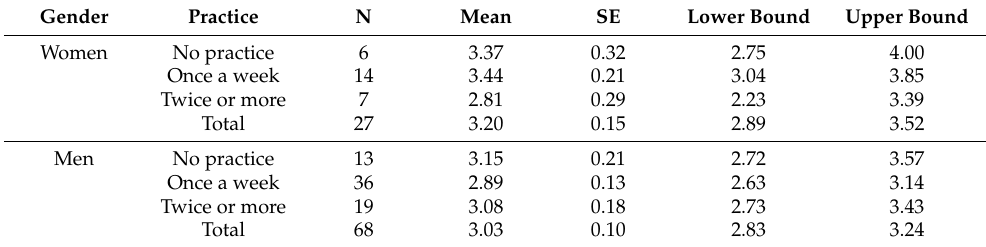
Table 4. Means and 95% confidence intervals for female and male goalkeeper responses on anxiety questions (five-point Likert scale) divided by the amount of practice of empty-goal scenarios. Gender Practice N Mean SE Lower Bound Upper Bound Women No